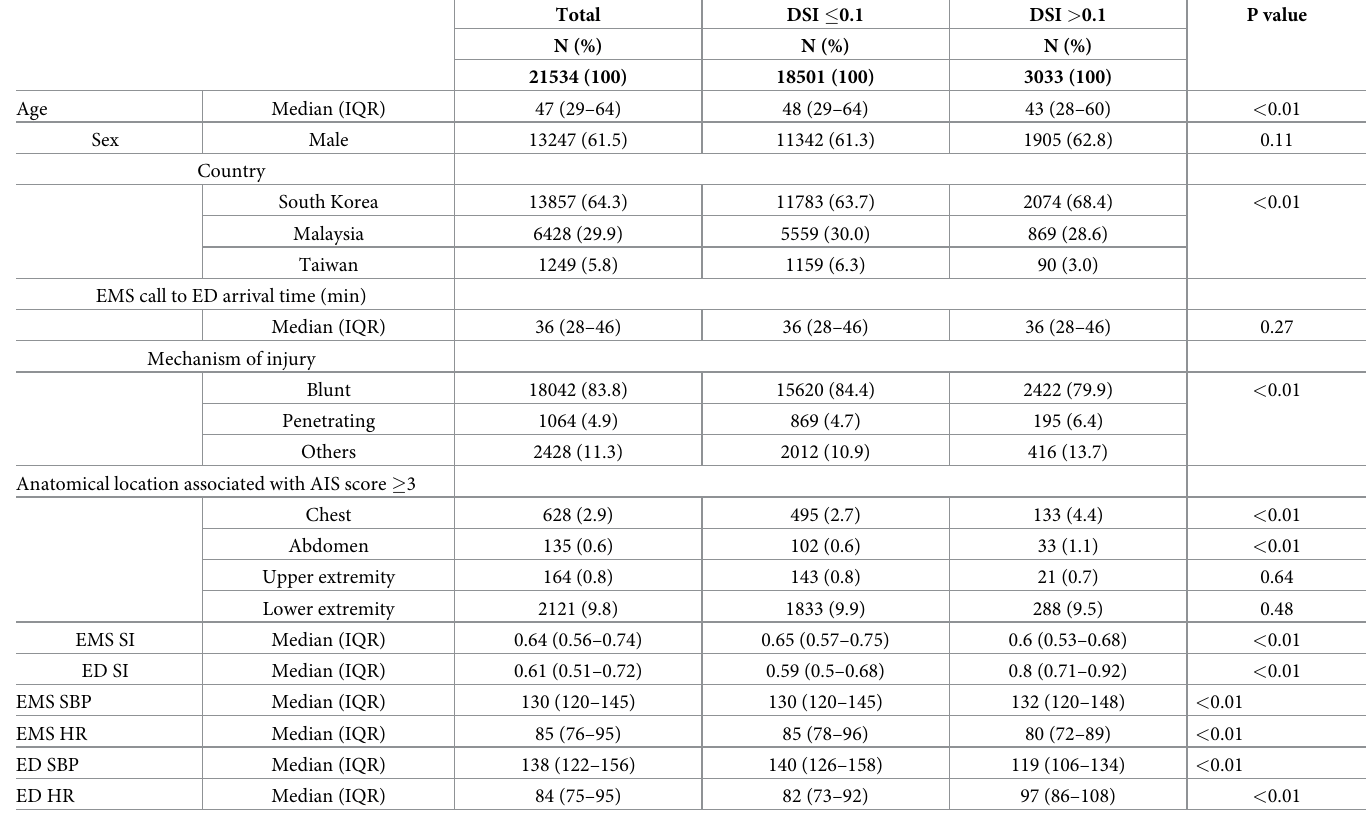
Table 1. Demographic findings according to exposure